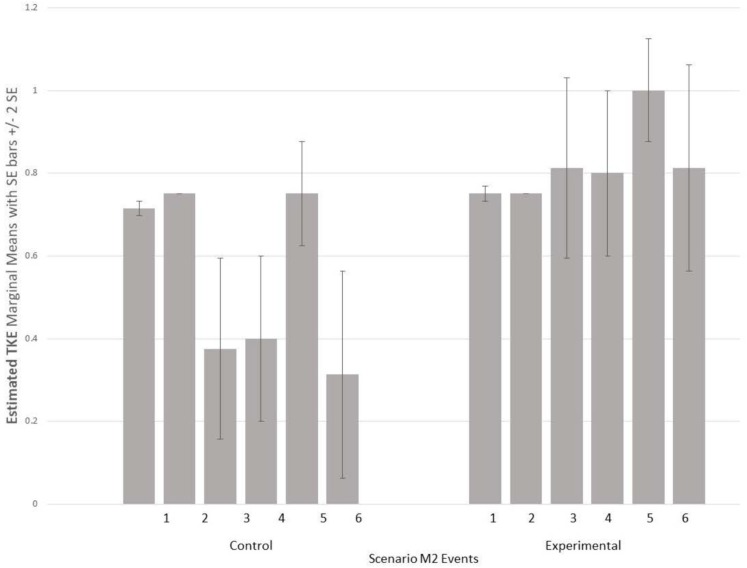
Estimated TKE marginal means and standard error for M2 scenario events.